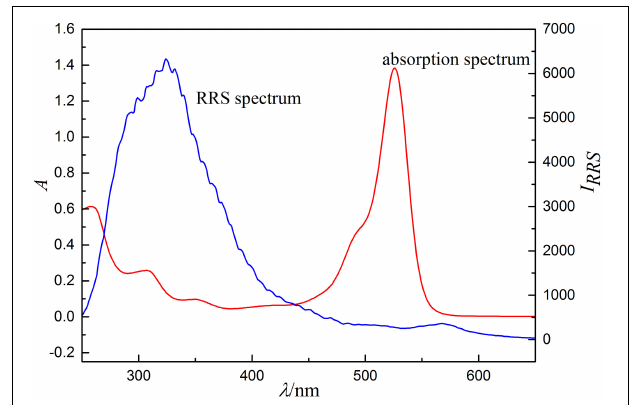
erythrosine is 2.5 × 10 − 5 mol/l, pH = 4.4, concentrations of Ag(I) is 0.500 µ g/ml.